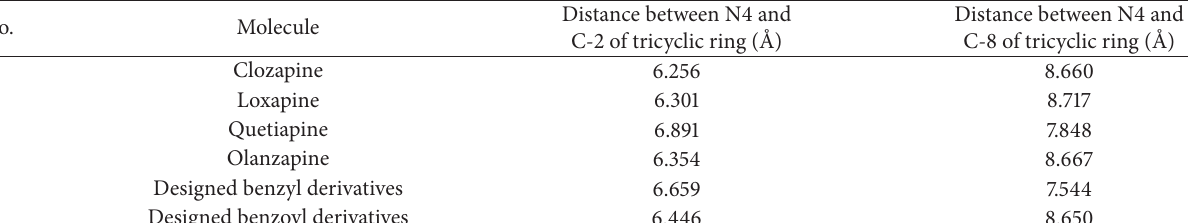
Table 1: The distance between N4 and C-2/C-8 of tricyclic ring.